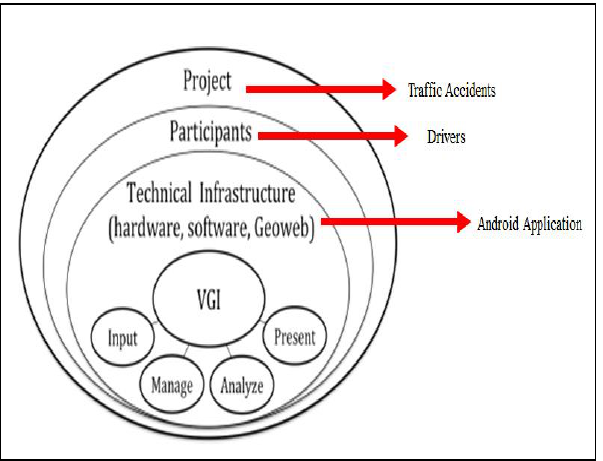
Figure 4. System Components